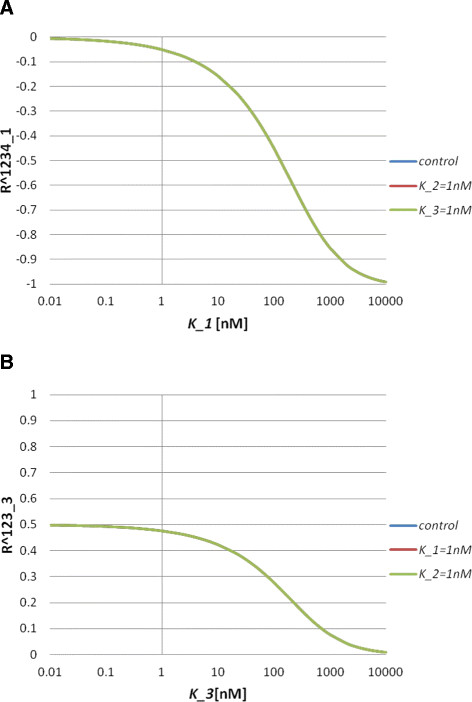
Behaviours of the response coefficients for Model C4. (A) Response coefficient R11234 as a function of K1 for different K2 and K3 values. Blue (control) line indicates K2 = K3 = 100nM, red line indicates K2 = 1nM, K3 = 100nM, and green line indicates K2 = 100nM, K3 = 1nM. (B) Response coefficient R3123 as a function of K3 for different K1 and K2 values. Blue (control) line indicates K1 = K2 = 100nM, red line indicates K1 = 1nM, K2 = 100nM, and green line indicates K1 = 100nM, K2 = 1nM.